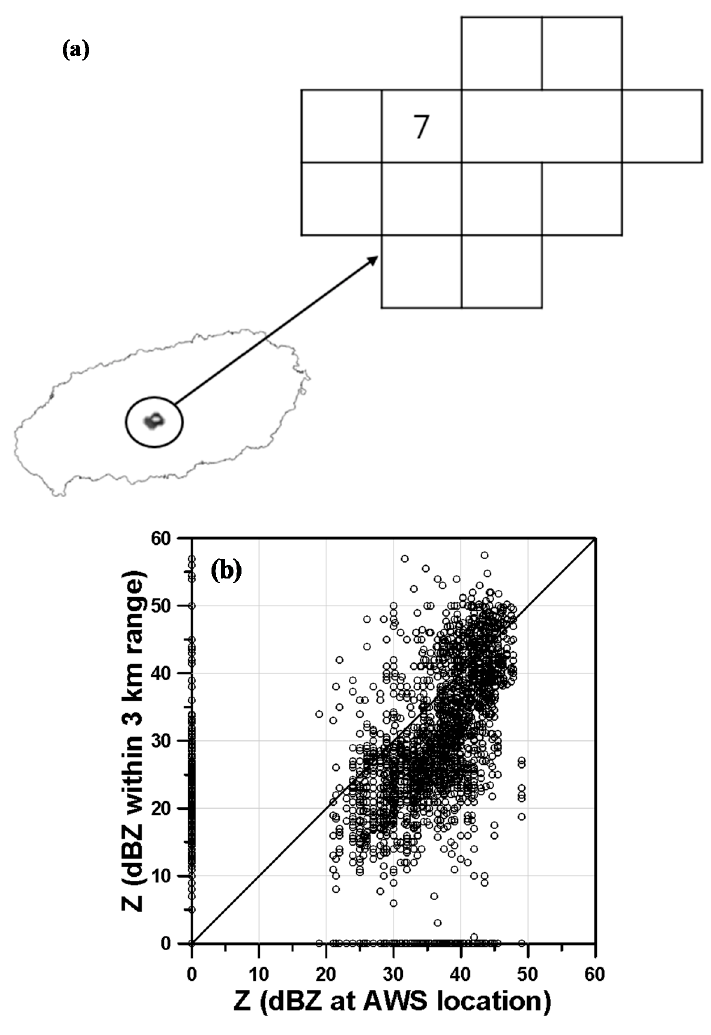
Figure 8. Cells around Witse Oreum (cell number 7) ( a ), and the scatter plot of radar reflectivity data at Witse Oreum and nearby cells within 3 km range ( b ).